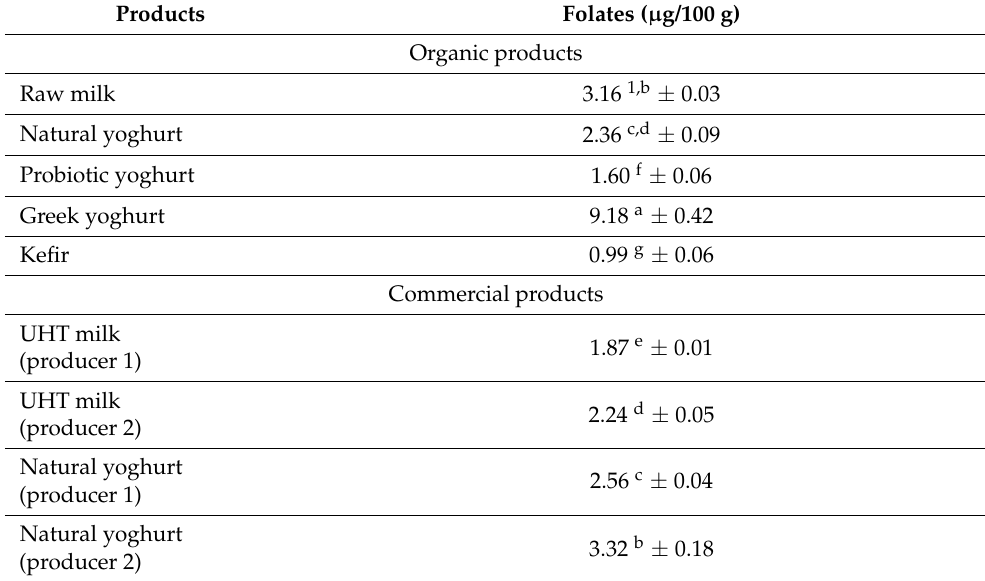
Table 4. Folate content in goat’s milk and fermented goat’s milk drinks (Mean ± SD). Products Organic